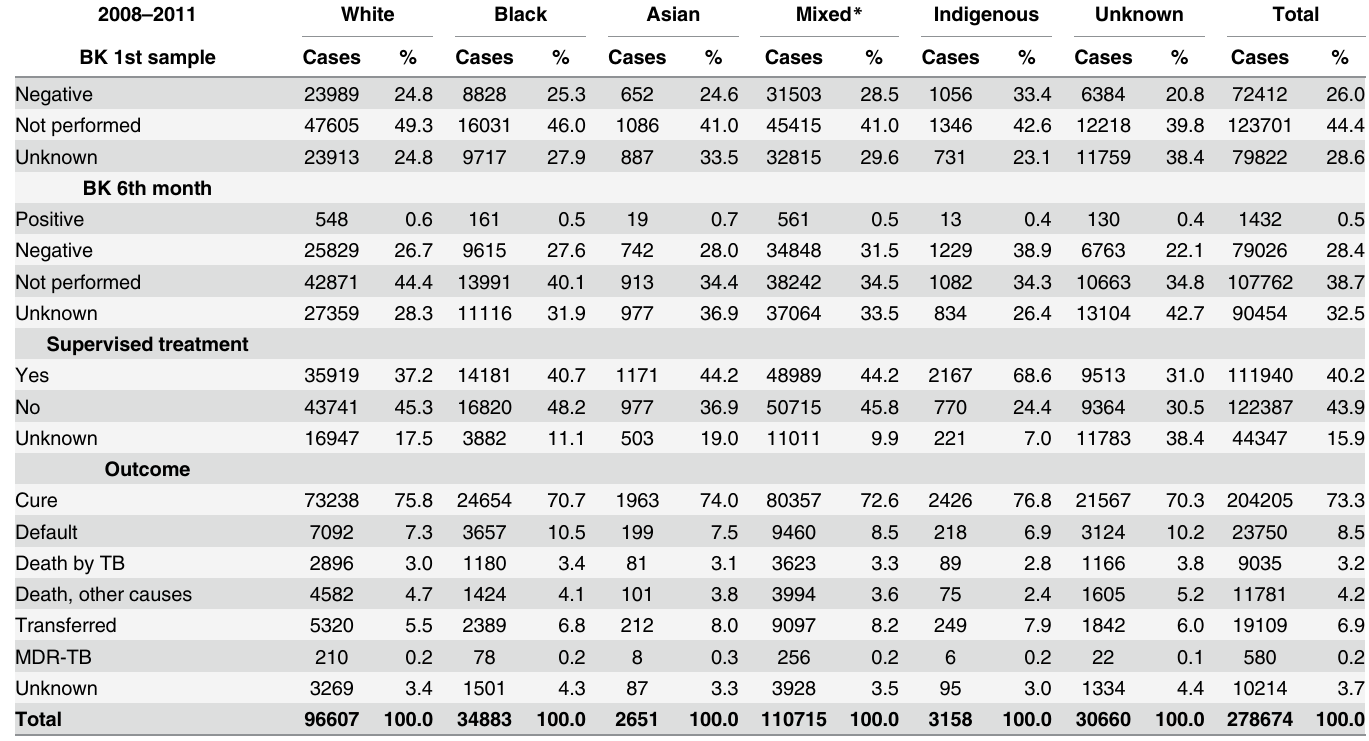
tests were not performed in more than half (56.7%) of all notified TB cases, with the highest rates of non-compliance in the black and the 'mixed' populations (both 64.6%) (Table 3). Pulmonary tuberculosis was reported in 82.3% of all cases, making it the most common clinical presentation of the disease among all colour/race categories. The highest rate of pulmo- nary tuberculosis was found in the indigenous population (86.6%). Extrapulmonary tuberculo- sis was predominantly reported in the white population (17%) compared to the other colour/ race categories (Table